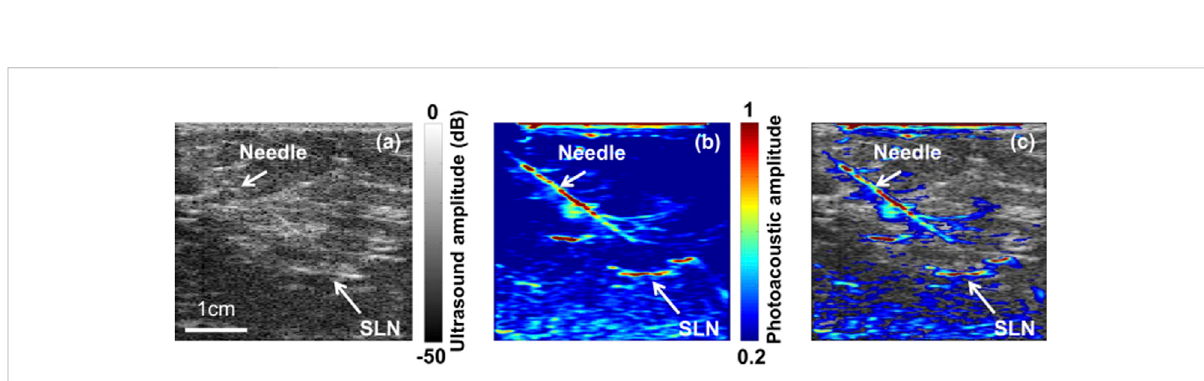
FIGURE 9 Images oftheSLNandtheneedleacquiredusingPAT/US invivo . (A) USimageshowingthelymph nodeandneedle invivo . (B) PATimageofthe SLNandneedle invivo . (C) CoregisteredPAT/USimageoftheSLN(longwhitearrow)andneedle(shortwhitearrow).SLN:sentinellymphnode;PAT: photoacoustic tomography; US: ultrasound. Reprinted with permission from [Garcia-Uribe A., et al. (2015). Dual-Modality Photoacoustic and Ultrasound Imaging System for Noninvasive Sentinel Lymph Node Detection in Patients with Breast Cancer. Sci Rep.5, 15748. doi: 10.1038/